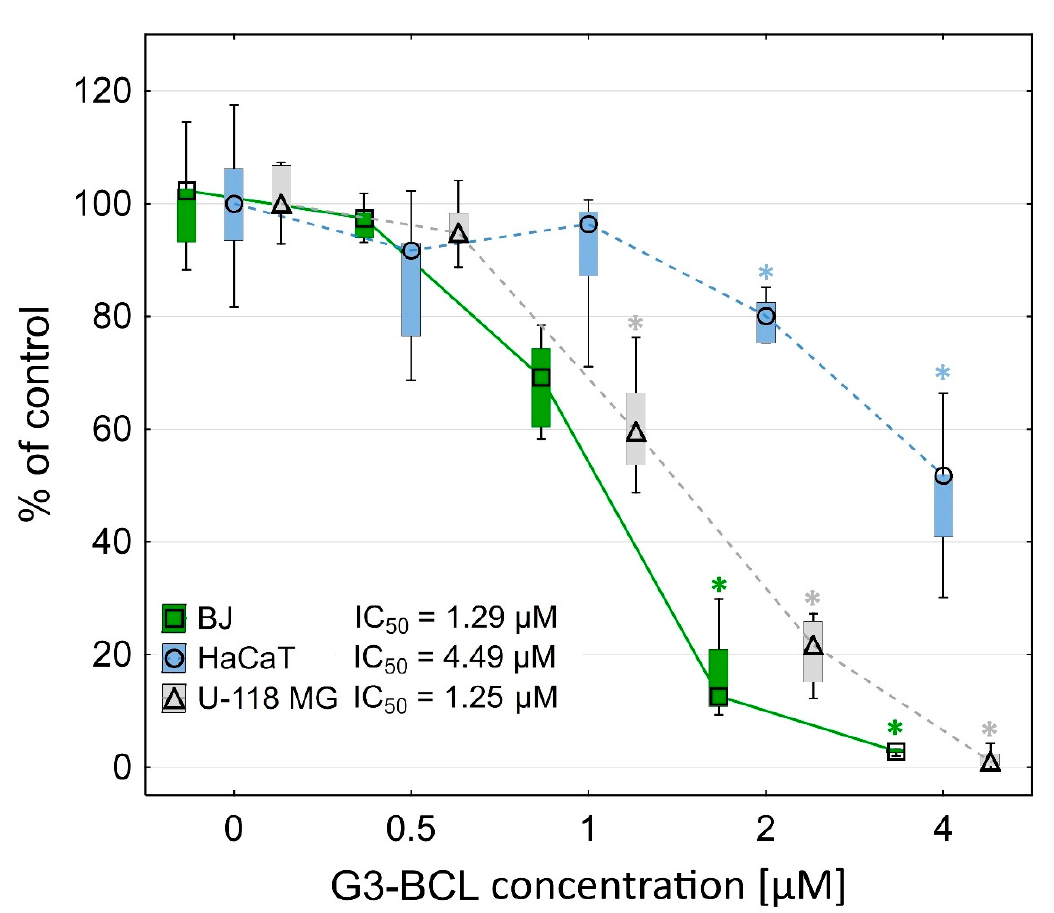
Figure 1. Cytotoxicity of G3-BCL conjugate for BJ, HaCaT and U-118 MG cells after 24 h treatment, estimated by XTT assay. Results are presented as median of triplicate assays from three independent experiments and expressed as % of non-treated controls. The whiskers are lower (25%) and upper (75%) quartile ranges. * P < 0.05; Kruskal-Wallis test.